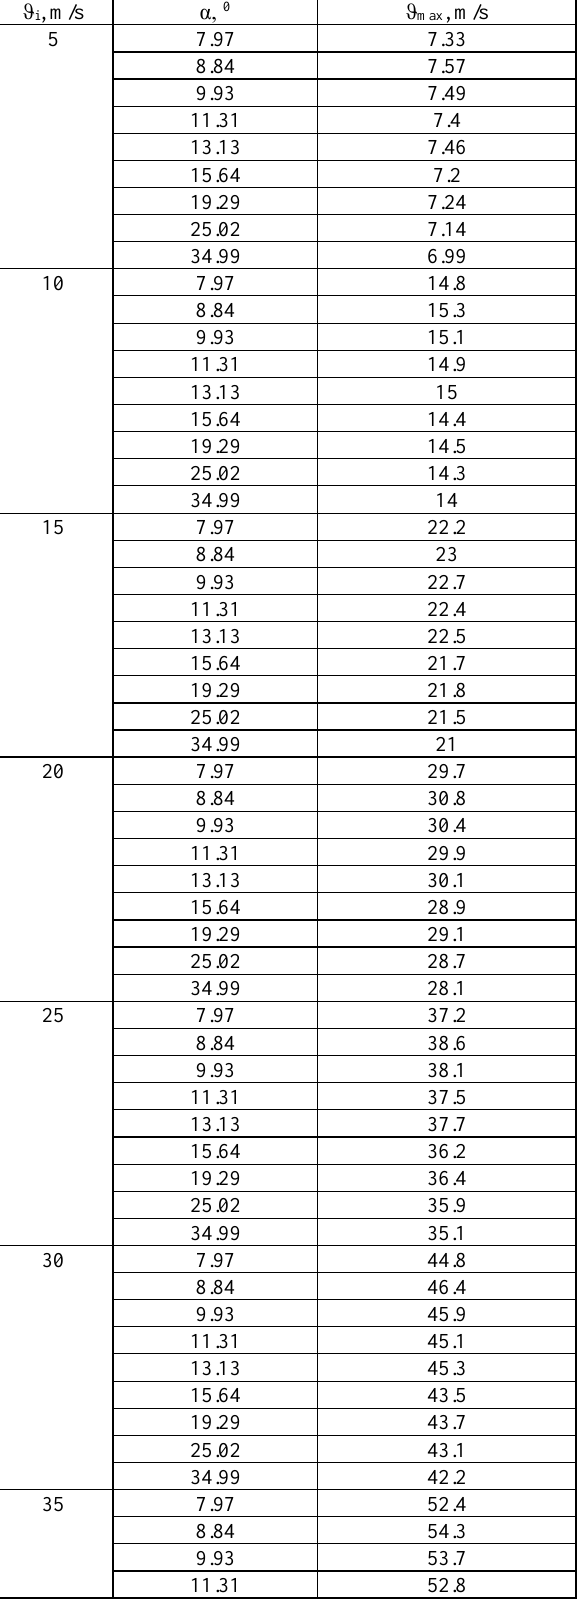
Table 1. Results of wind speed in the turbine area ϑ i ,